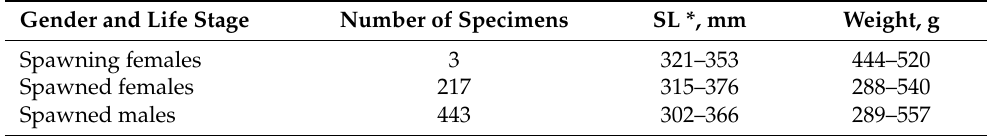
Table 1. Main characteristics of Baikal omul from the Selenga River (data from October 2013). Gender and Life Stage